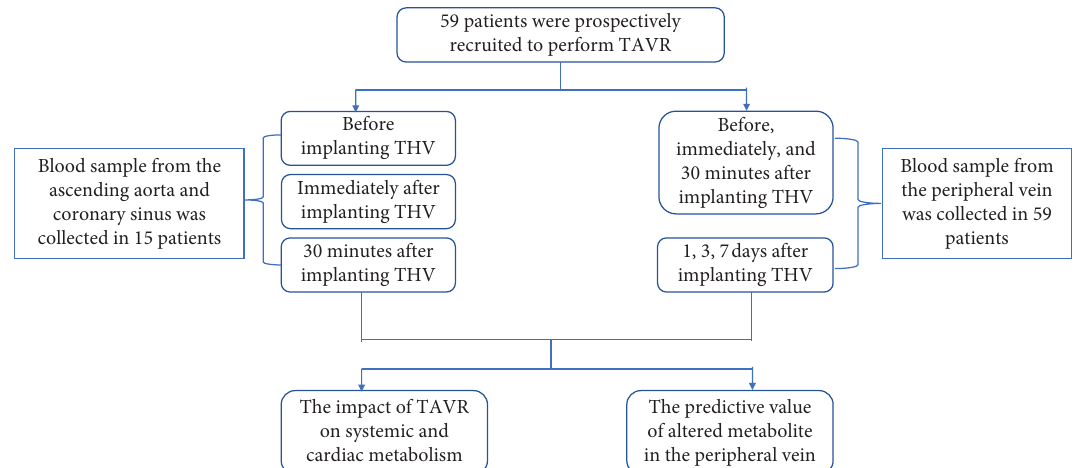
Figure 1: Brief protocol of the prospective study. TAVR, transcatheter aortic valve replacement; THV, transcatheter heart